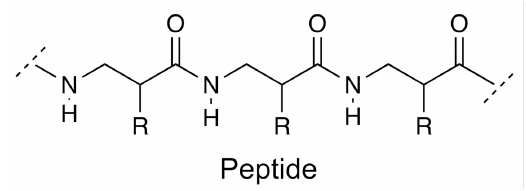
Figure 10. The chemical representation for a